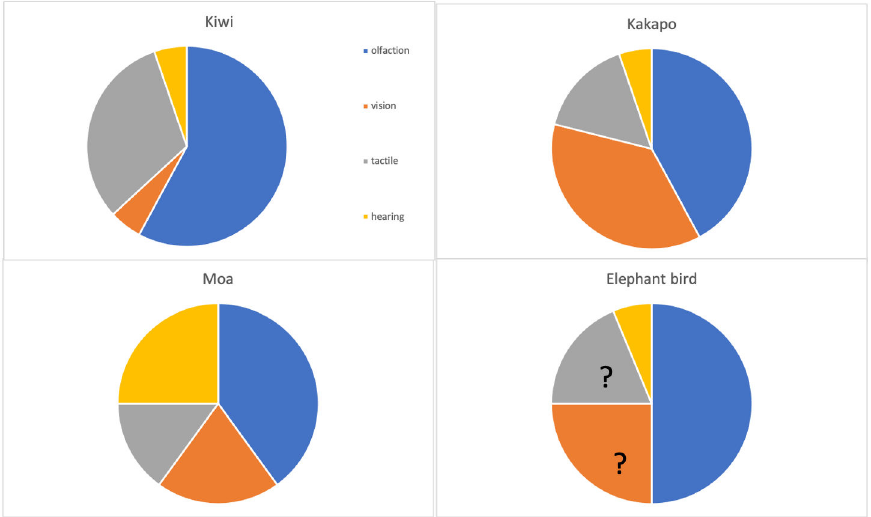
Figure 14. Possible patterns of sensory modalities, based on new date and published information on sensory organs, neural structures and observed behavior. ? =